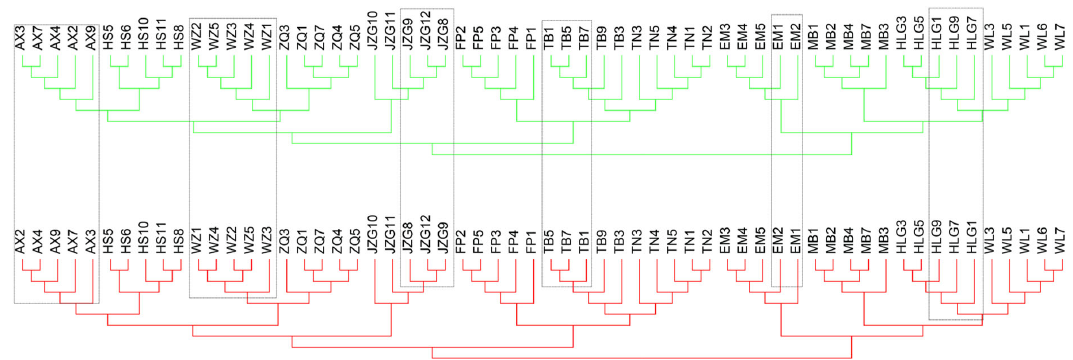
Figure 3. Haplotype phylogenies observed in K. uniflora based on 114,746 SNPs . The phylogenetic trees constructed based on phased haplotype A and B sequences are highlighted with red (haplo ‐ type A) and green (haplotype B) color, respectively. The differences between the two tree topologies are marked using rectangles with dashed lines.